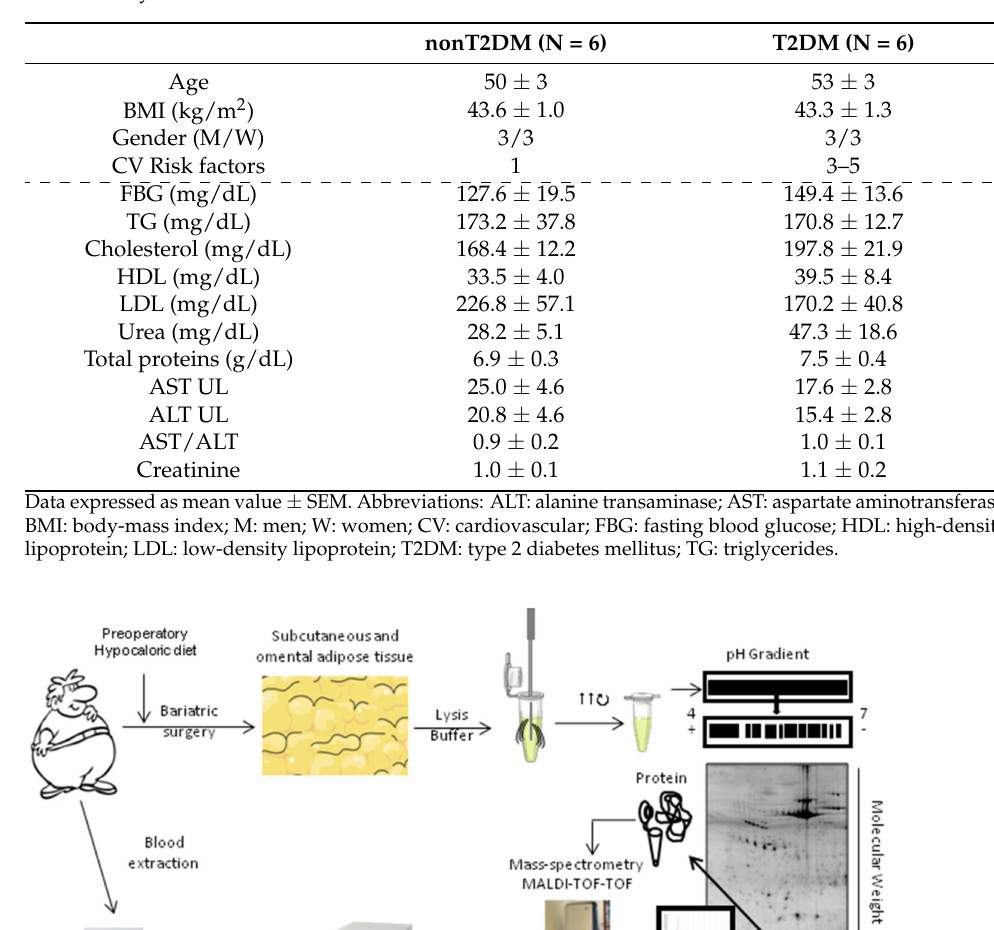
Table 7. Demographic description and clinical parameters of the individuals included in the pro- teomic analysis.